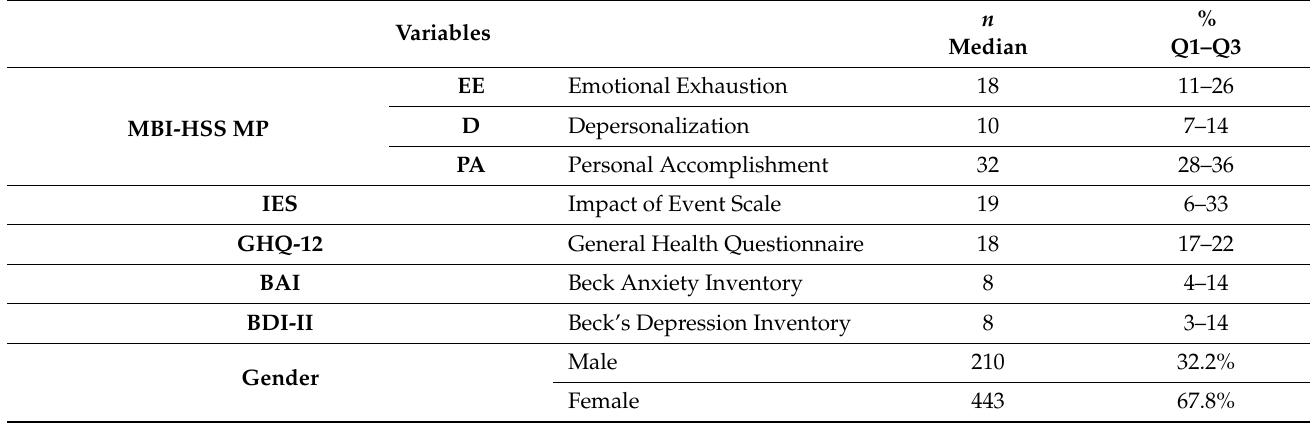
Table 1. Descriptive data of the sample, including socio-demographic and work-related variables. The median and quartiles (Q1–Q3) have been reported for the continuous variables and the absolute with relative % frequencies for the categorical